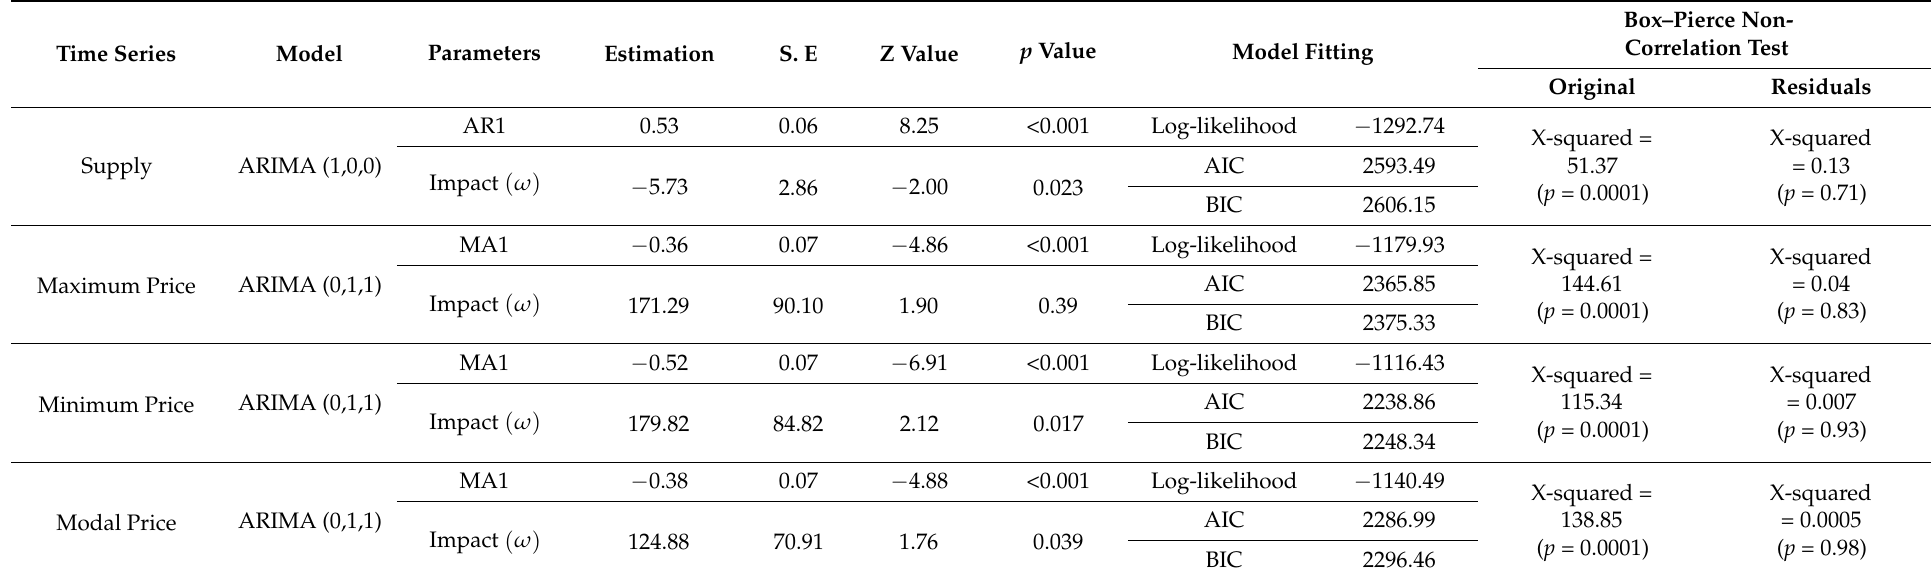
Table 4. Parameter estimation of ARIMA intervention